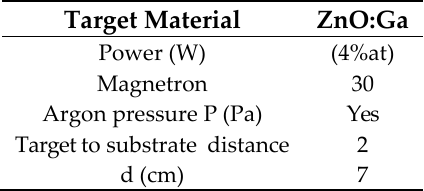
Table 1. Deposition parameters of ZnO:Ga thin film by RF-sputtering.